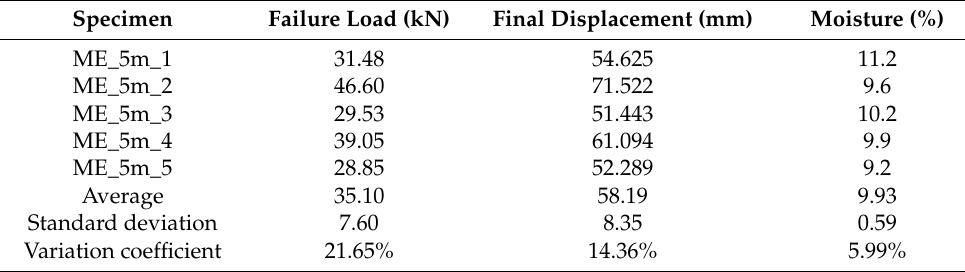
Table 2. Perforated samples—MP_5m